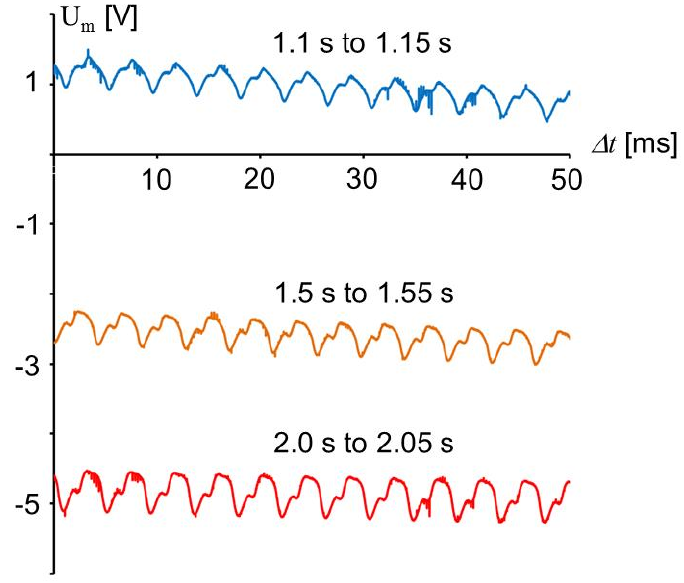
Figure 13. Parts of the signal shown in Figure 10 at different times shown with larger resolution. The corresponding time range from Figure 10 is shown next to the